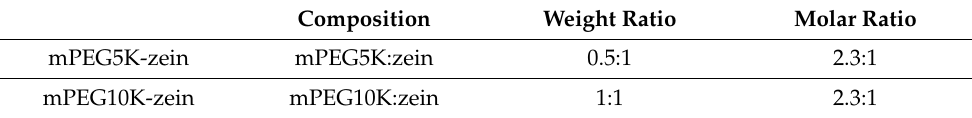
Table 1. Composition of the two mPEG-zein synthesized in the study. Composition Weight Ratio Molar Ratio mPEG5K-zein mPEG5K:zein 0.5:1 2.3:1 mPEG10K-zein mPEG10K:zein